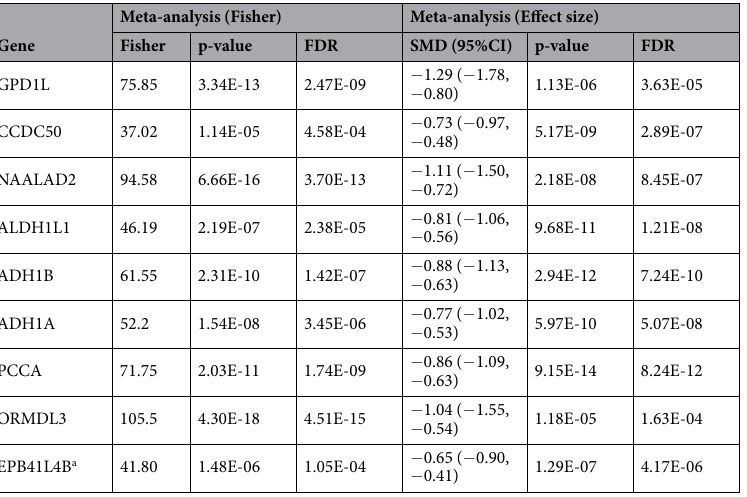
Table 2. The results of meta-analysis for hub genes in the Yellow module. SMD, standardized mean difference. a One of 97 BMI loci identified by